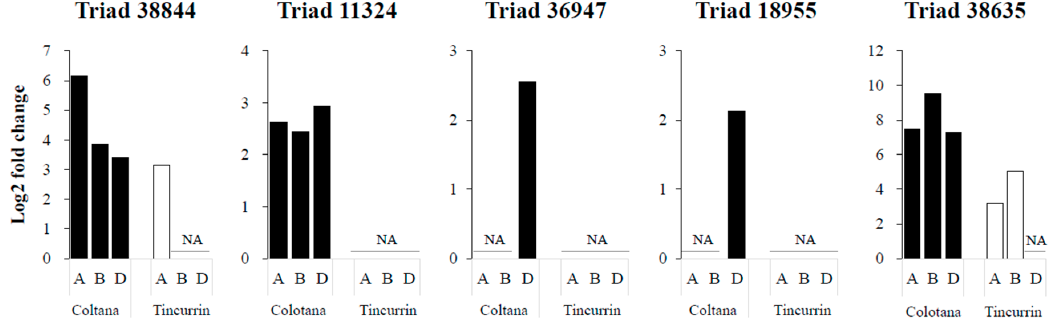
Figure 4. Di ff erence of gene expression patterns of homoeologous genes under water stress in Colotana and Tincurrin genotypes. The relative expression of Triads 38,844, 11,324, 36,947, 18,955, and 38,635 in two genotypes is shown. The x-axis shows homoeologous genes and the y-axis shows relative expression. Each bar shows the relative expression in roots of Colotana (black) and Tincurrin (white) at 6 h.